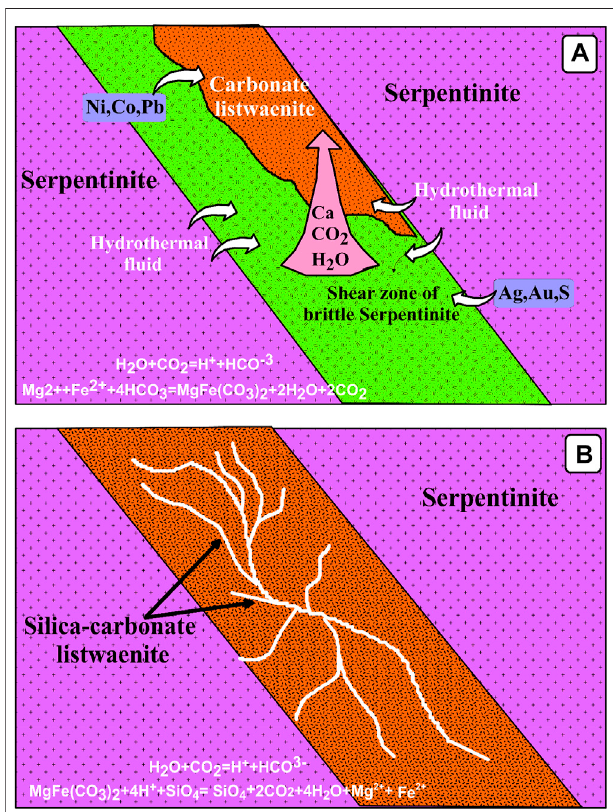
FIGURE20| Cartoonforanidealized petrogeneticmodel oflistwaenites (after Ucurum et al., 1996) in the wadi Allaqi, Southeastern Desert of Egypt, based on fi eld observations, petrography, and geochemistry. (A) Serpentinite protolith breaksdown and ischanged to carbonate-rich listwaeniteform as CO 2 -rich hydrothermal fl uids in fi ltrate through and precipitate Mg-Fe-Ca carbonatesinitsplace.Goldisreleasedintoasolutionassociatedwithsul fi de. (B) Silica-rich listwanites form because the hydrothermal fl uids are protected from the serpentinite by the precipitation of carbonates in the initial phase of alteration. As a result, fl uids become increasingly acidic, encouraging carbonate breakdown and the precipitation of silica, sul fi des, and gold.